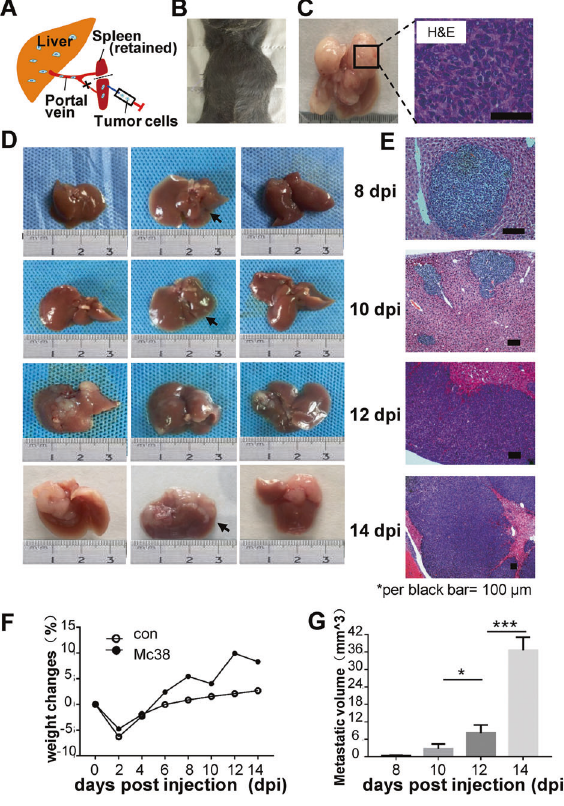
Fig. 1 The mouse liver metastasis model and its dynamic disease course. A The liver metastasis model in C57BL/6 mice. Mc38 colorectal cancer cells were injected via the spleen-portal vein into the liver. B At 21 days post injection (dpi), the abdomen of a tumor- bearing mouse showed large tumor bumps. C H&E staining showed huge and non-necrotic liver metastases. Up to 14 dpi, the liver metastases appeared as small to large-sized tumors on the liver surface; arrows pointed to liver metastases ( D ); and under the microscope by H&E staining ( E ). F The weight changes in the control and Mc38-injected mice during disease (weight changes were shown in the mean value of 4 mice per group). G Metastases volumes in the liver were calculated by measuring the tumor sizes